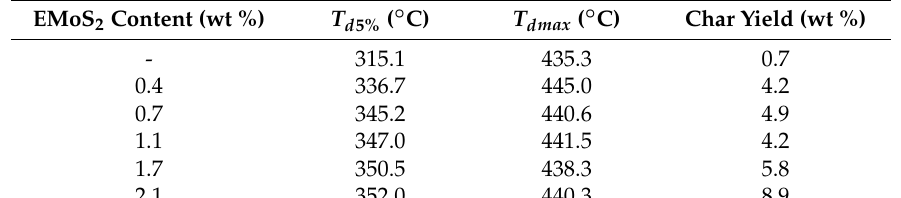
Table 2. Effect of EMoS 2 content on the thermal stabilities of PP/EMoS 2 nanocomposites.